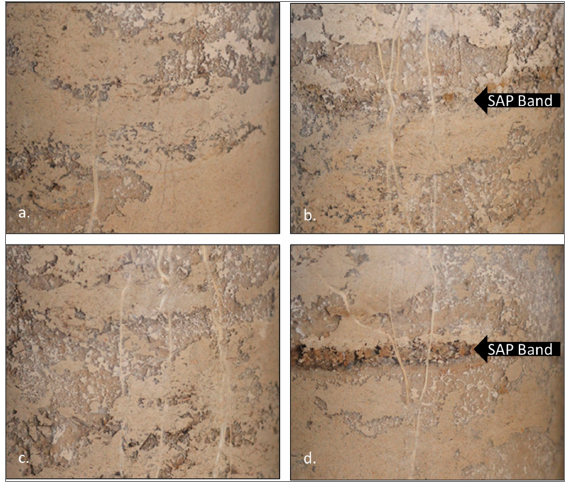
Figure 8. Seedling roots 5–12 cm below soil surface 51 d after planting: ( a ) bottlebrush squirreltail control, ( b ) bottlebrush squirreltail with 3000 kg ha − 1 SAP band placed at 8 cm depth, ( c ) Siberian wheatgrass control, ( d ) Siberian wheatgrass with 3000 kg ha − 1 SAP band placed at 8 cm depth.